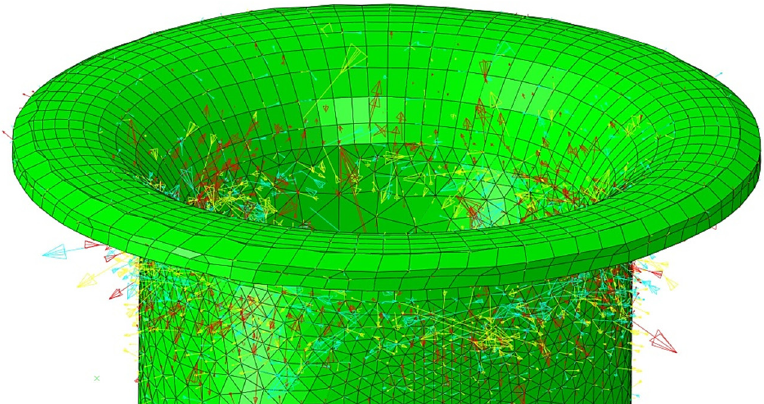
Figure 6. The direction of stress at the end stage of the forming process.